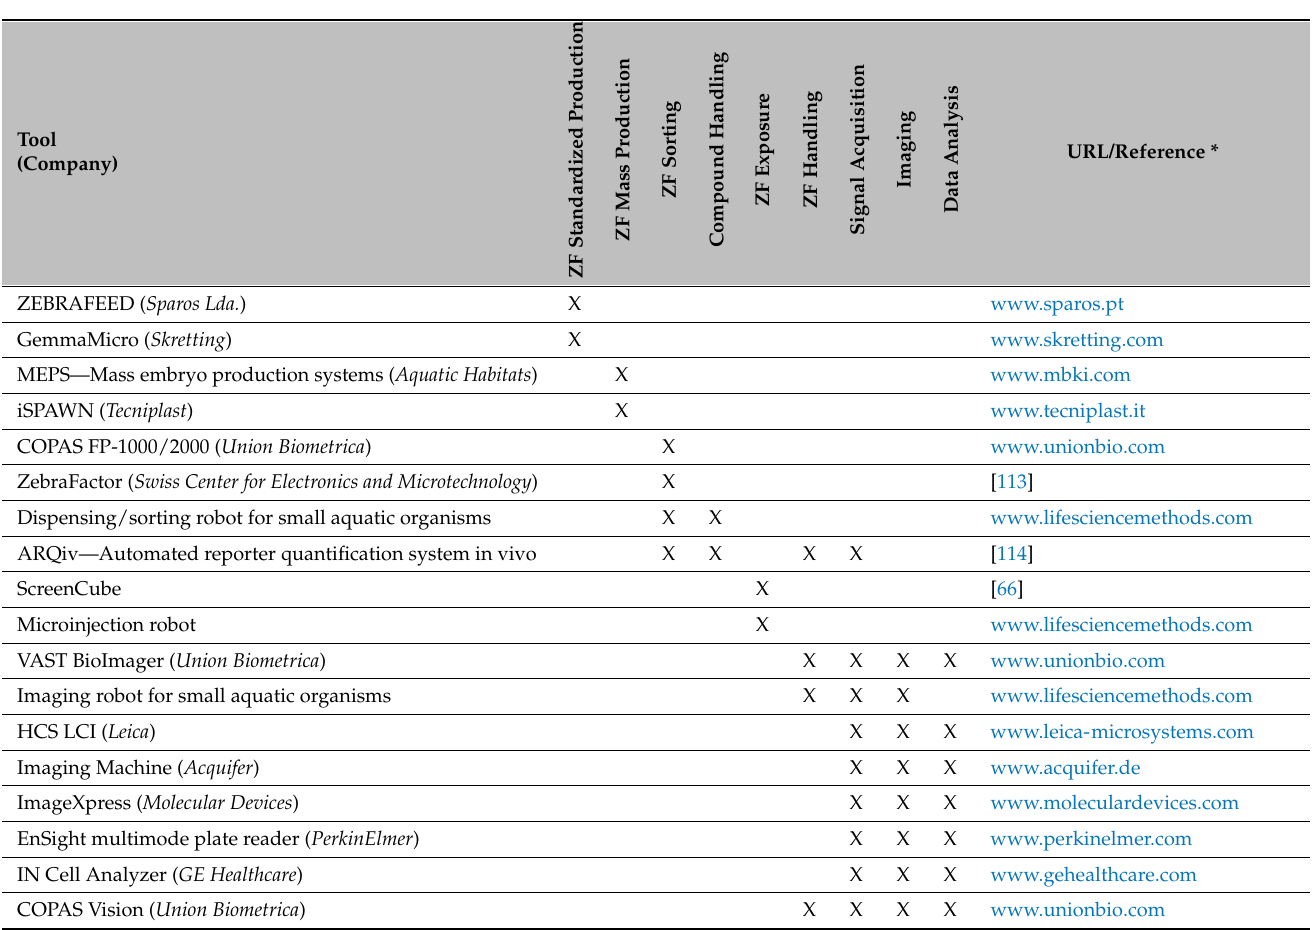
Table 2. Tools to improve the throughput and accuracy of in vivo screenings in zebrafish (all web pages accessed on 22 May